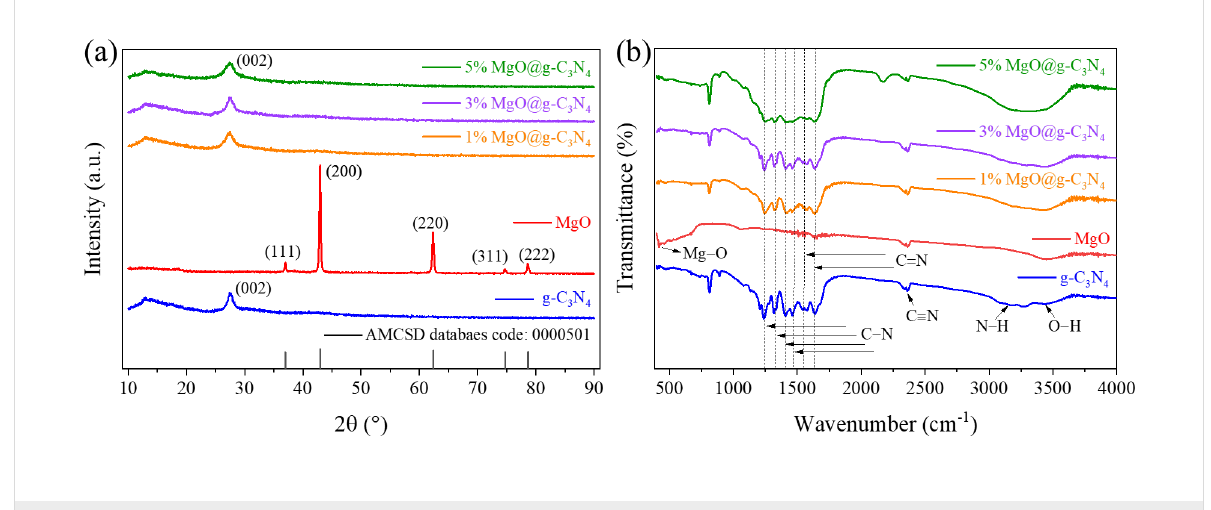
Figure 4: (a) XRD patterns and (b) FTIR spectra of the materials.